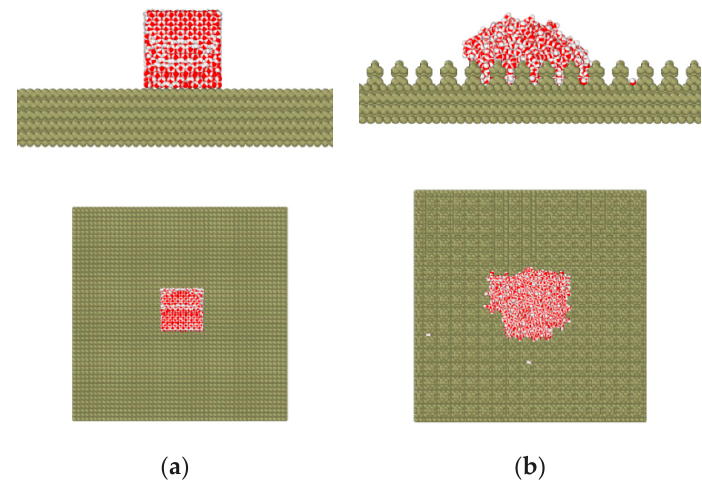
Figure 4. The schematics of the simulation model: ( a ) initial model and ( b ) model after simulation.